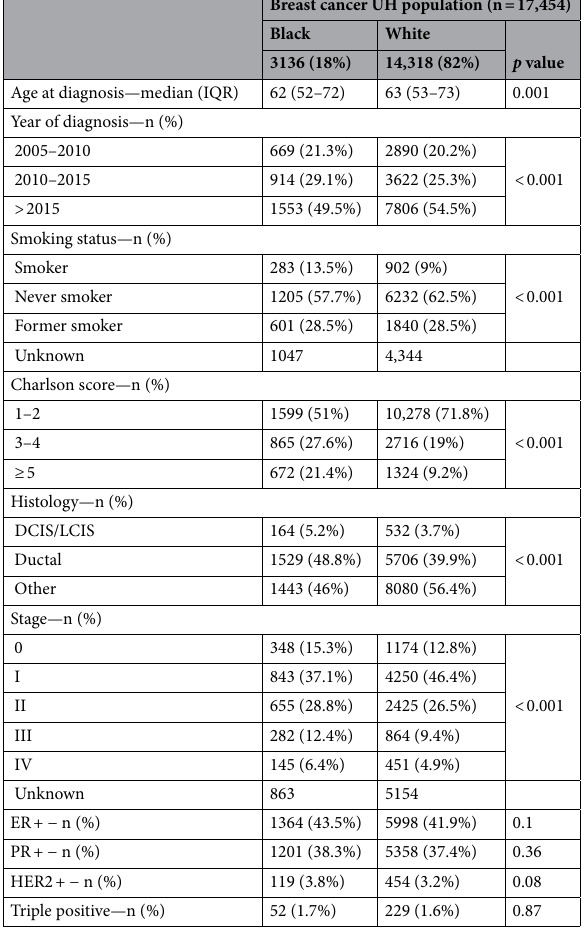
Table 1. Breast Cancer University Hospitals (UH) population (2005–2022) description and comparison stratified by race in demographics and tumor characteristics. A total of 17,454 patients were analyzed, with 3,136 (18%) self-reporting as Black. IQR interquartile